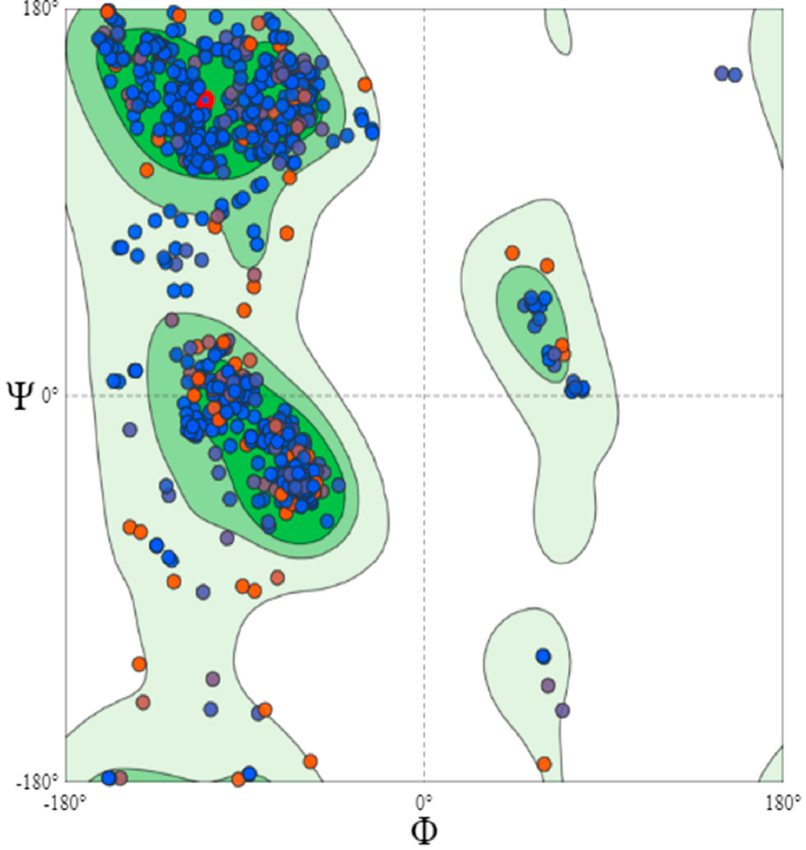
Figure A2. General Ramachandran plot for acetylcholinesterase model for structural assessment. The Ramachandran plot is a plot of the torsional angles (phi ( φ ) and psi ( ψ )) of the residues (amino acids) contained in a peptide.